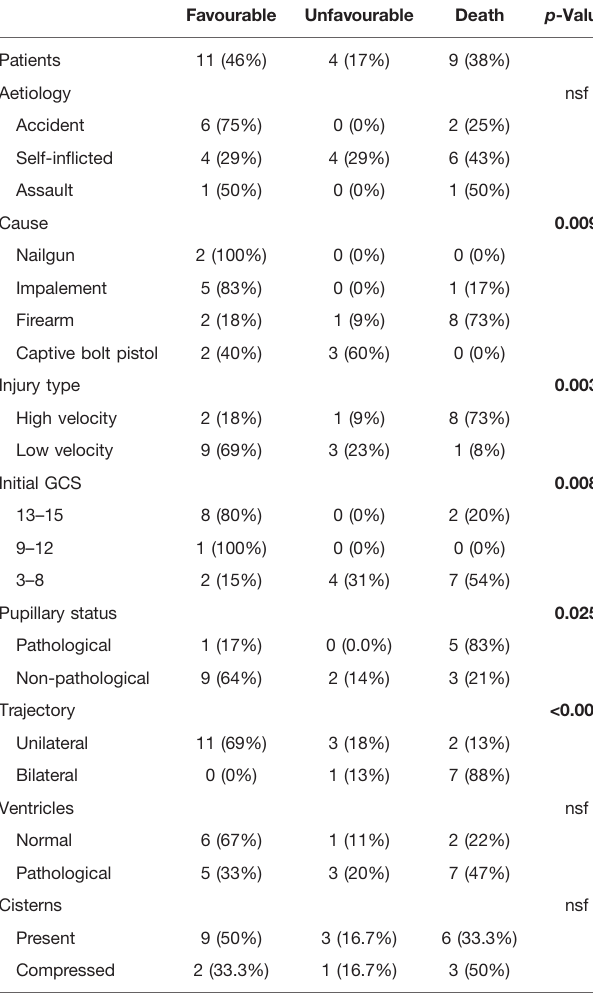
Bold values indicate signi fi cant fi